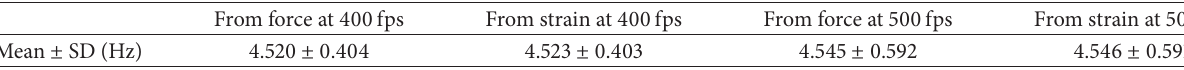
Table 1: X-MET’s spontaneous contraction. Mean ± SD of X-MET’s spontaneous contraction measured using the force response with reference to the acquired images, at both 400fps and 500 fps. 𝑛 = 4 .